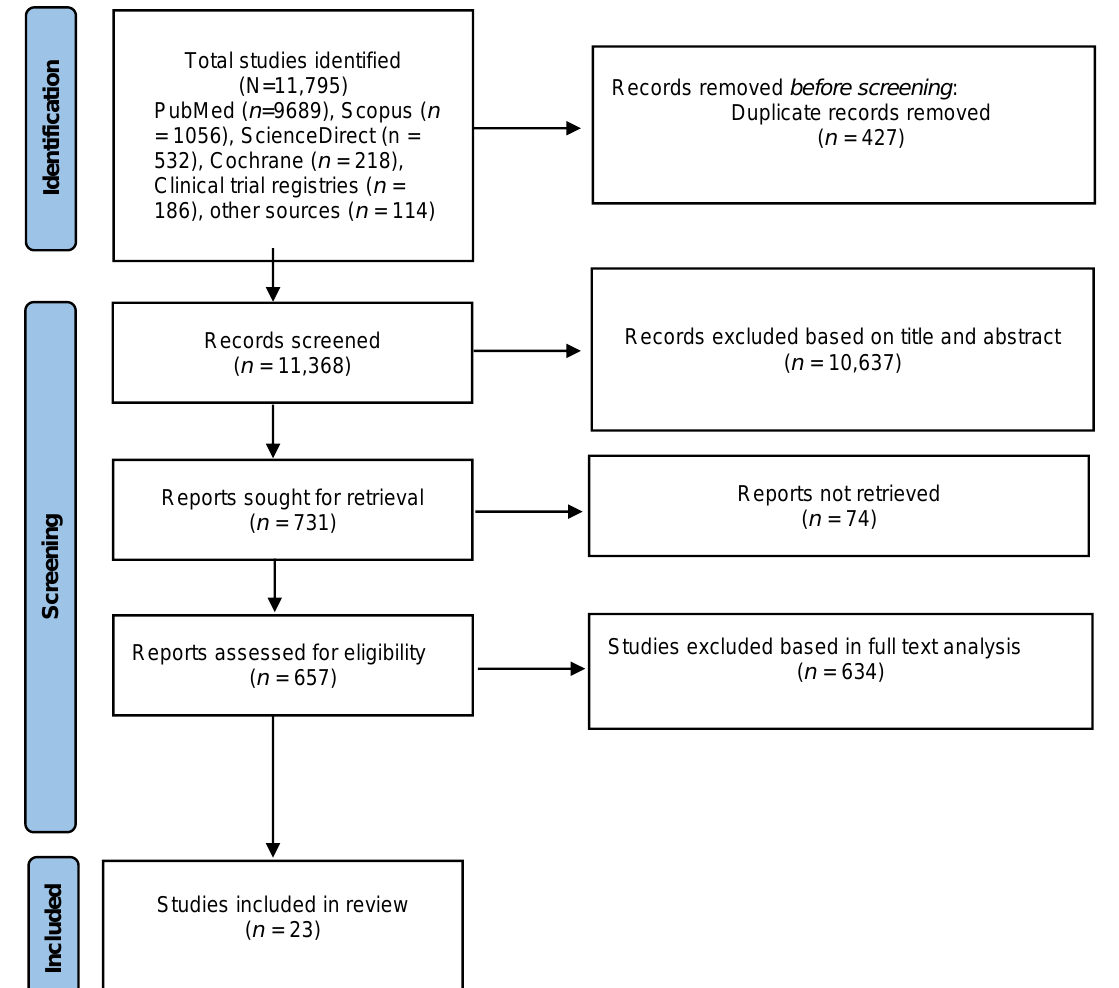
Figure 1. Flow chart of the included studies.